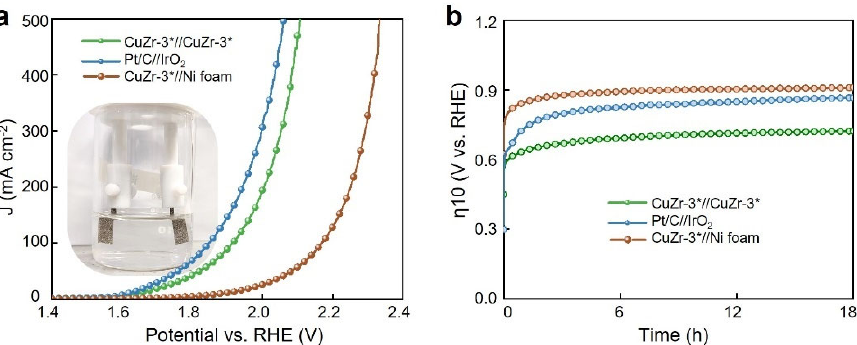
Figure 5. Water splitting reaction. ( a ) The LSV curves of Pt/C//IrO 2 , CuZr − 3*//CuZr − 3* and CuZr − 3*//Ni foam cells. ( b ) The chronopotentiometry curves of the two cells measured at applied current density of 10 mA cm − 2 .